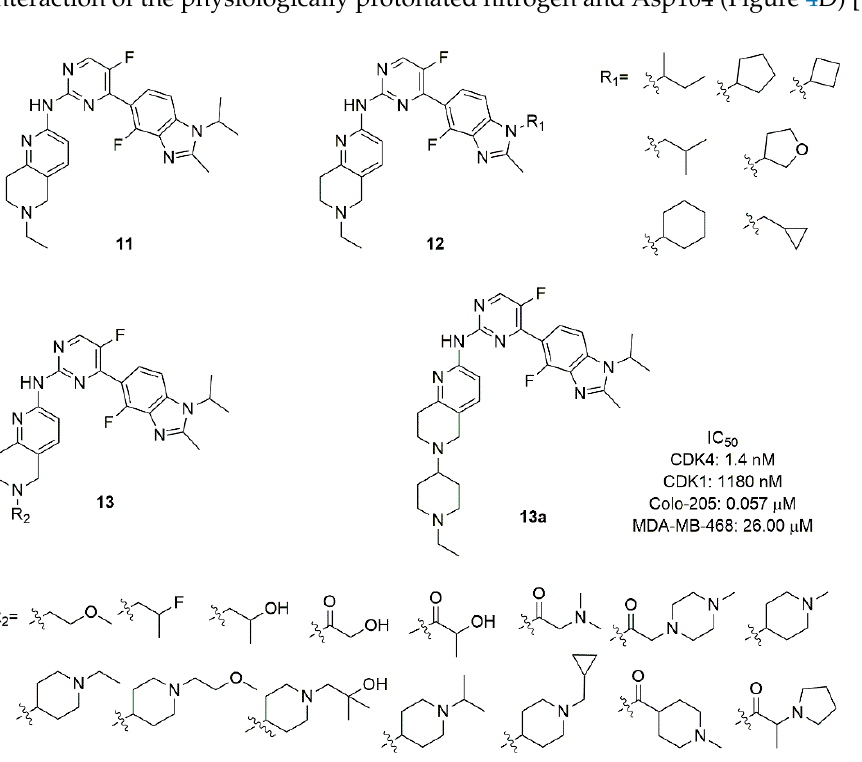
Figure 6. CDK4/6 inhibitors based on benzimidazolyl-pyrimidine scaffold.